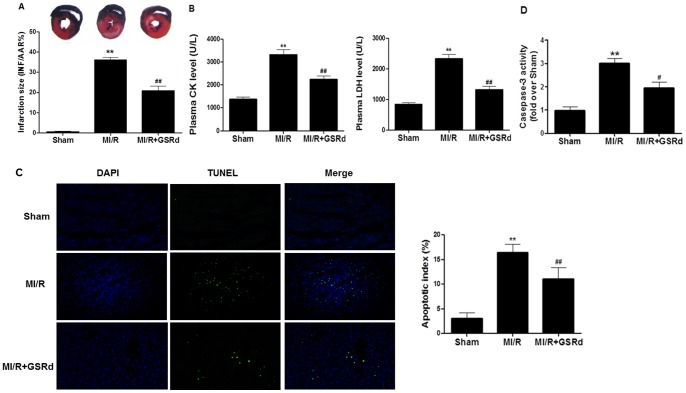
Ginsenoside Rd reduced rat myocardial injury (infarct size, necrosis, and apoptosis) post MI/R.(A) Myocardial infarct size in rats subjected to 30 minutes I, followed by 3 hours R. Blue-staining represents non-ischemic tissue, red-staining represents the area at risk, and pale areas indicate infracted regions. Myocardial infarct size (INF) expressed as percentage of area at risk (AAR). (B) Plasma creatine kinase (CK) and lactate dehydrogenase (LDH) levels. (C) Left: Representative photomicrographs of in situ detection of apoptotic cardiomyocytes by terminal deoxynucleotidyl nick-end labeling (TUNEL) staining in MI/R heart tissue. Green fluorescence indicates TUNEL-positive apoptotic nuclei; blue fluorescence indicates total cardiomyocyte nuclei. Original magnification 200×; Right: Percentage of TUNEL-positive nuclei in heart tissue sections. (D) Myocardial caspase-3 activity. All values presented are mean ± SEM. n = 8/group. **P<0.01 vs. Sham, #
P<0.05, ##
P<0.01 vs. MI/R.